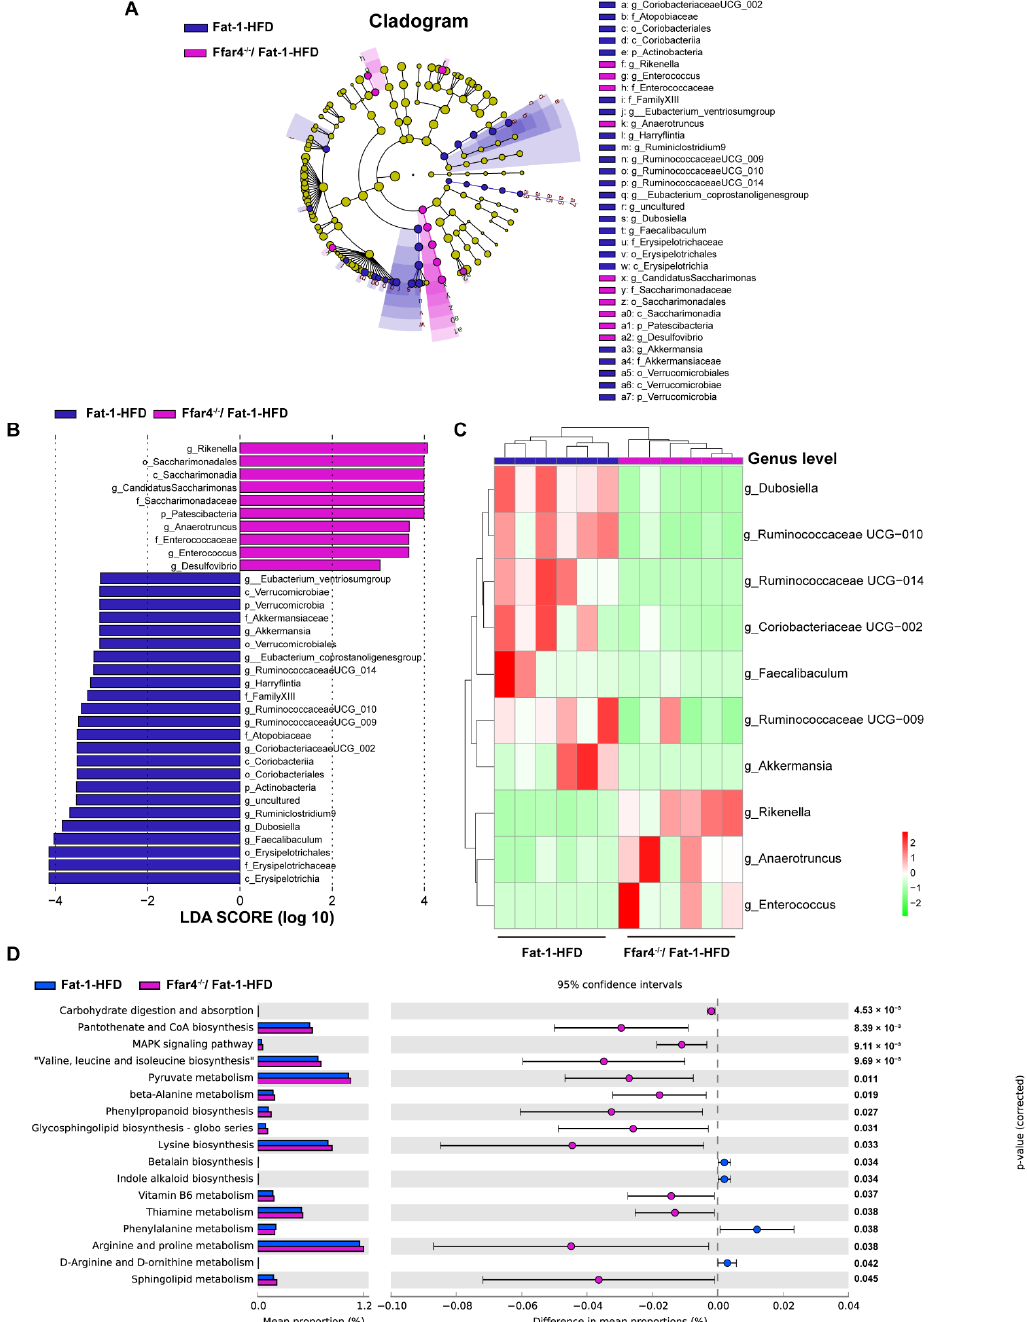
Figure 4. Gut microbial composition and microbial functional pathways. ( A ) Linear Discriminant Analysis (LDA) effect size (LEfSe) analysis between the Fat-1-HFD and FFAR4 − / − /Fat-1-HFD groups (LDA score > 2 and p < 0.05). ( B ) Taxonomic cladogram was performed to identify the differen- tially abundant taxa. ( C ) Heat map of the differentially genus level (Top 10) between two groups. ( D ) Differential pathways between the Fat-1-HFD and FFAR4 − / − /Fat-1-HFD groups ( p < 0.05). Results are presented as mean ± SD ( n = 6 for each